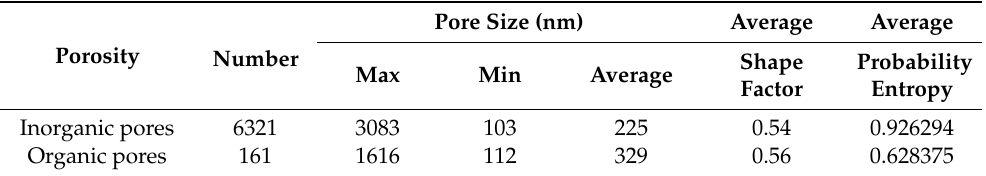
Table 2. Average pore parameters of organic pores and inorganic pores obtained from K 2 n 1+2 by PCAS software.